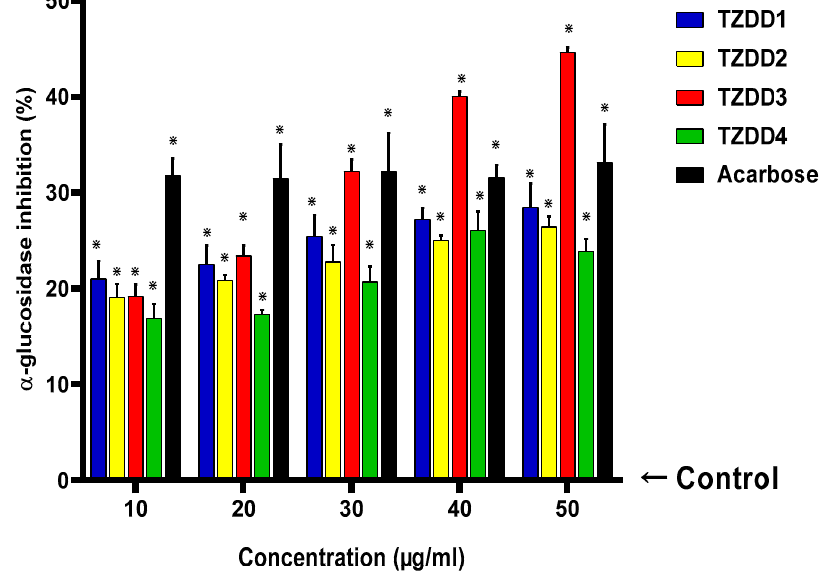
Figure 2. The inhibition of α -glucosidase activity by TZD-derivatives (10, 20, 30, 40, and 50 µg/mL). The results are represented in a clustered column. Data are presented as mean ± standard deviation values. The error bars correspond to the standard errors of the means, and asterisks (*) indicate a significant statistical difference relative to the control experiment ( p value ≤ 0.05). The arrow from the right pointing at the baseline at 0.0 represents the negative control, which is defined to have zero percent inhibition for the purpose of data normalization.